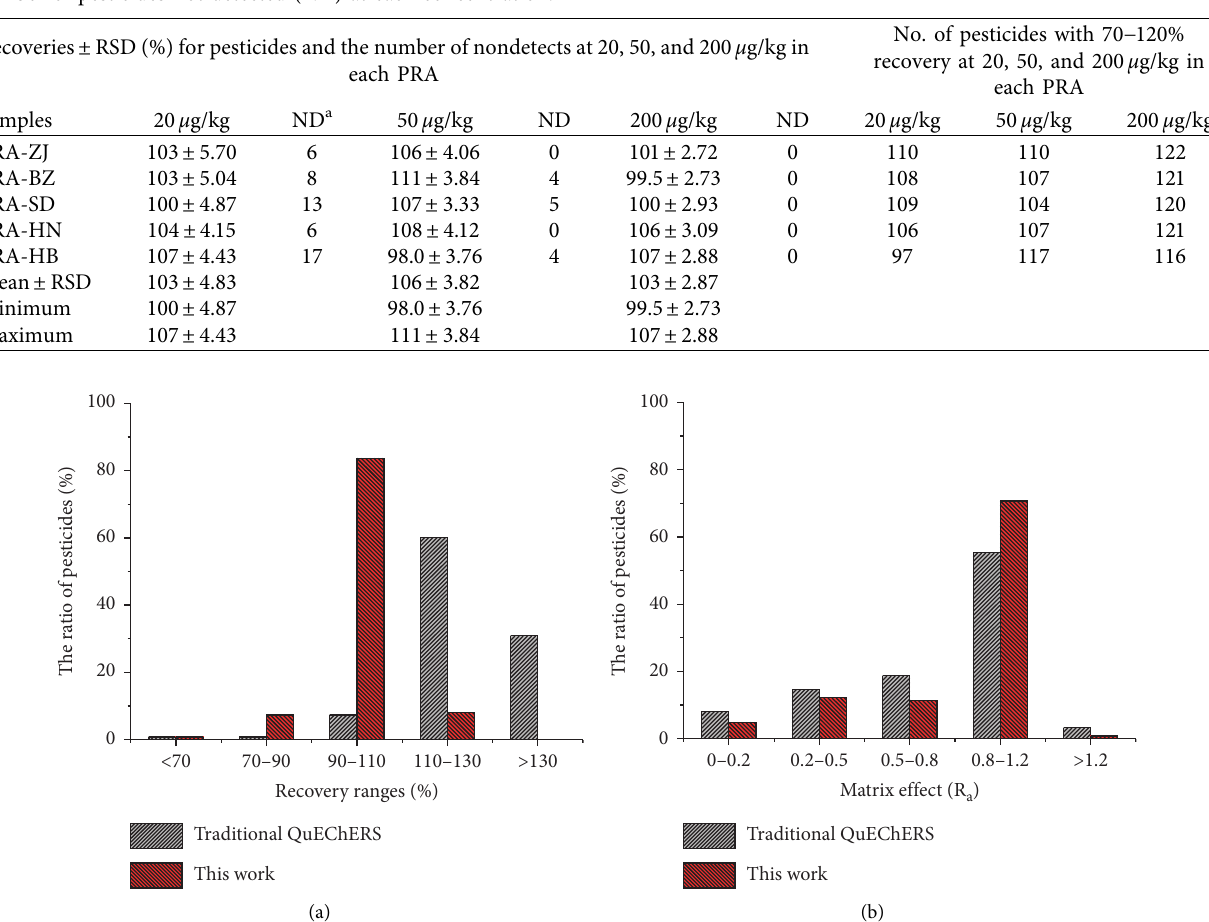
Table 1: Recoveries of the spiked pesticides from the various PRA samples at pesticide concentrations of 20, 50, and 200 μ g/kg and the number of pesticides not detected (ND) at each concentration.